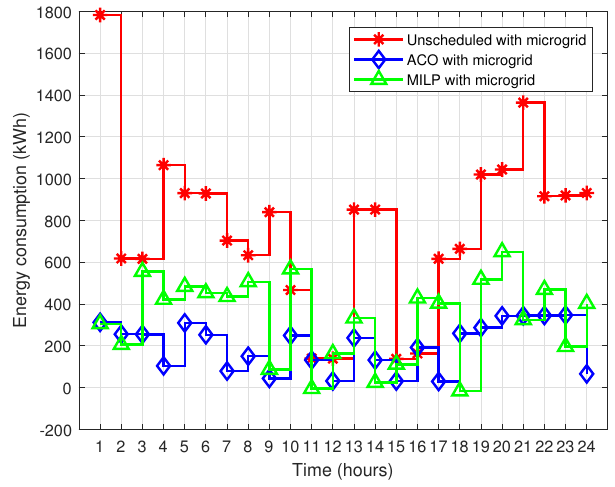
Figure 17. Users’ energy consumption considering